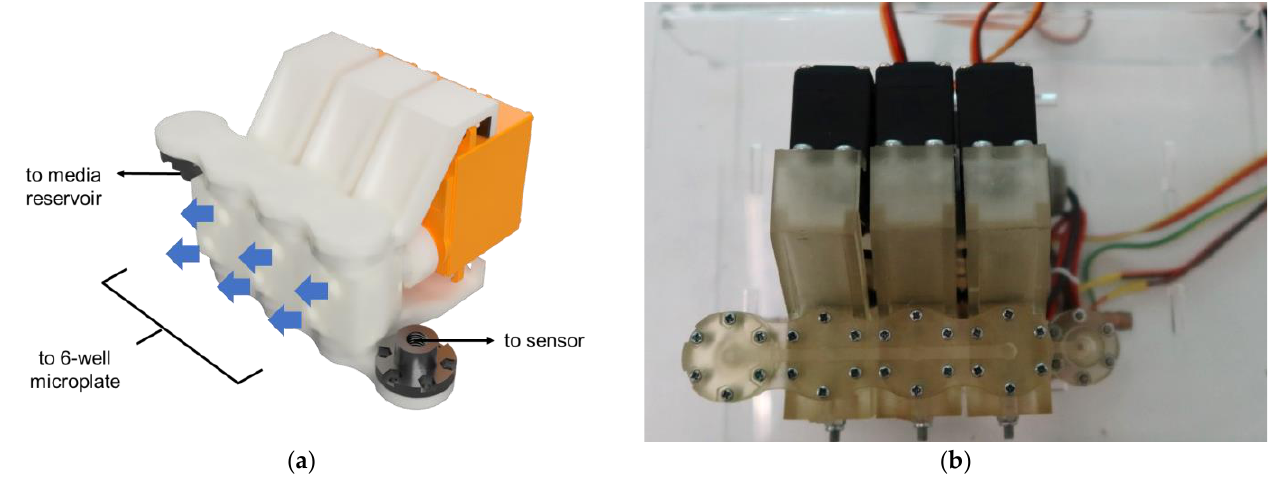
Figure 4. Selector: ( a ) a CAD file of a selector design; ( b ) a photo of a selector with 3D-printed chan- nels.